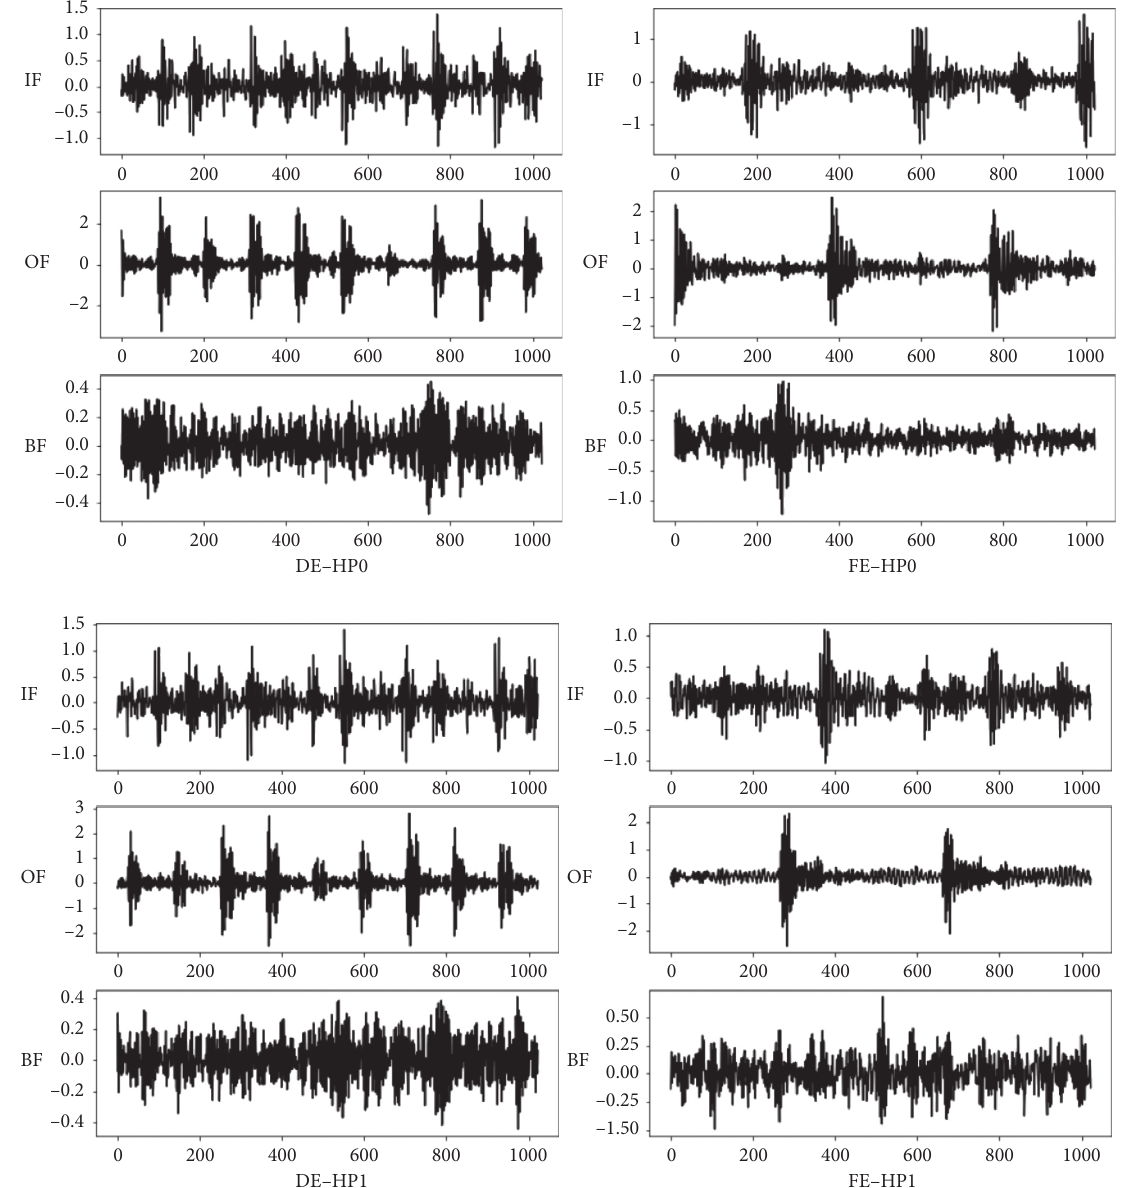
Figure 6: Time-domain vibration samples for three categories of faults under four working conditions.